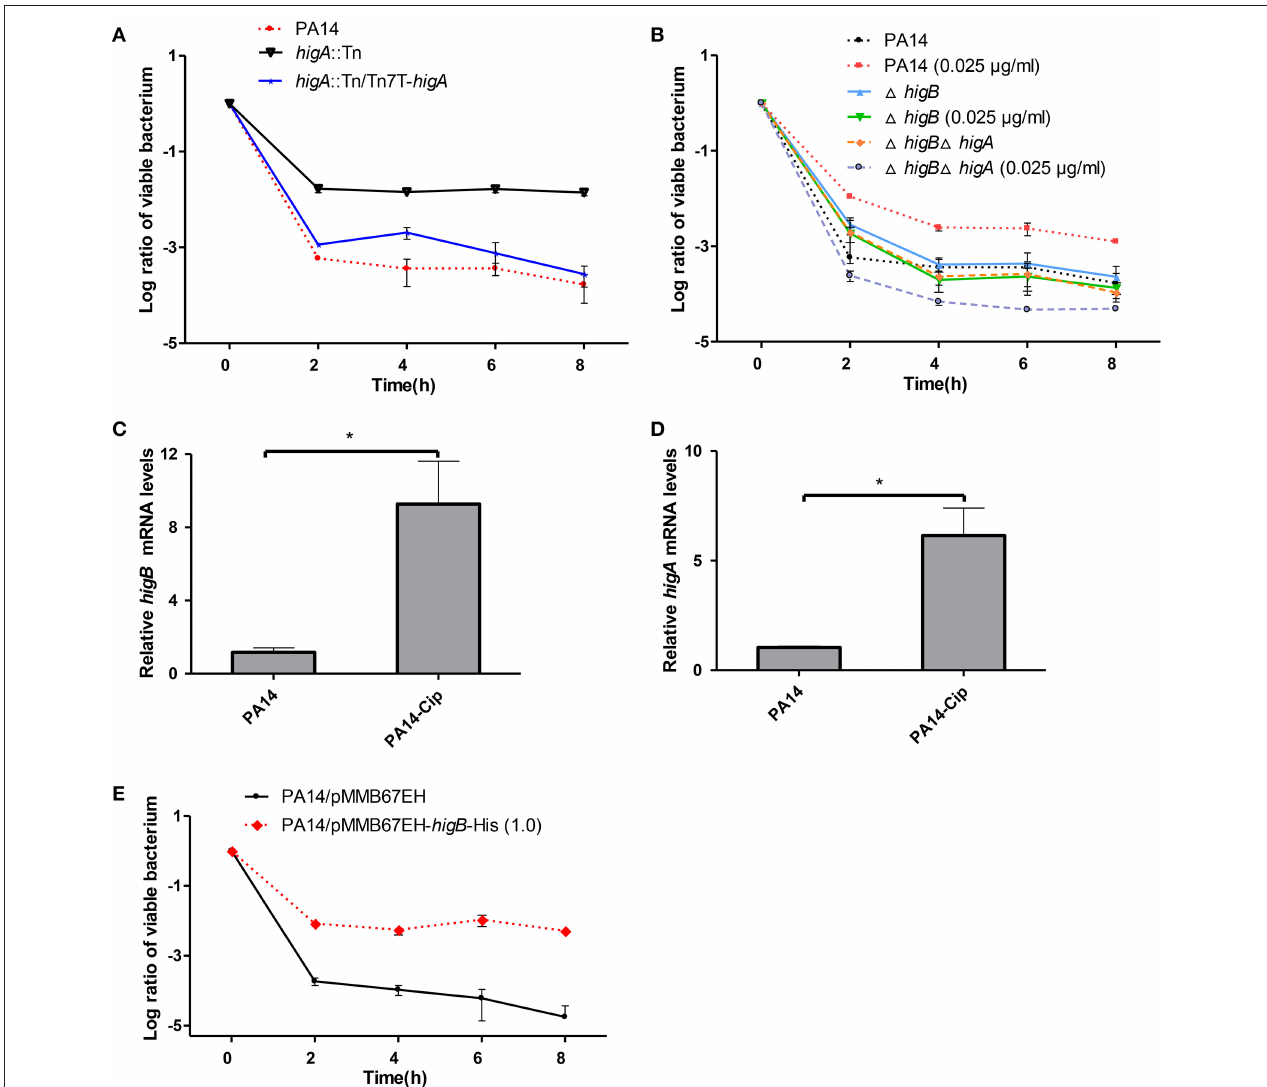
FIGURE 2 | Role of HigA-HigB in persister formation. (A) Wild type PA14, a higA ::Tn mutant and a complemented strain were treated with 0.25 µ g/ml ciprofloxacin. At indicated time points the survival rates were determined by plating assay. (B ) Wild type PA14, the 1 higA and 1 higA 1 higB mutants were cultured in the presence or absence of 0.025 µ g/ml ciprofloxacin for 2h and then treated with 0.25 µ g/ml ciprofloxacin. The survival rates were determined by plating assay. (C,D) Wild type PA14 was treated with 0.025 µ g/ml ciprofloxacin for 2h and the mRNA levels of higB or higA were determined by quantitative RT-PCR. Error bars represent the standard error. * p < 0.05, by Student’s t -test. (E) Wild type PA14 carrying a P tac driven higB gene or the empty vector were cultured with 1mM IPTG for 2h, followed by treatment with 0.25 µ g/ml ciprofloxacin. The survival rates were determined by plating. Error bars represent the standard errors. The graphs are representatives of three independent